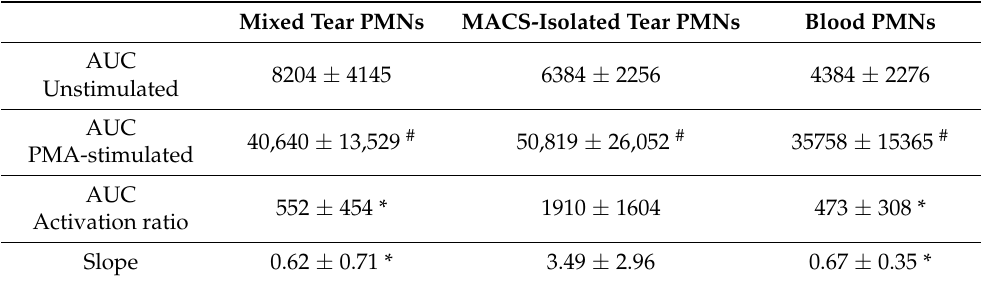
Table 3. Absolute and relative ROS production in unstimulated and PMA-stimulated PMNs, as measured by AUC. Mixed Tear PMNs MACS-Isolated Tear PMNs Blood PMNs AUC 8204 ± 4145 4384 ± 2276 Unstimulated AUC 40,640 ± 13,529 # 50,819 ± 26,052 # 35758 ± 15365 # PMA-stimulated AUC Activation